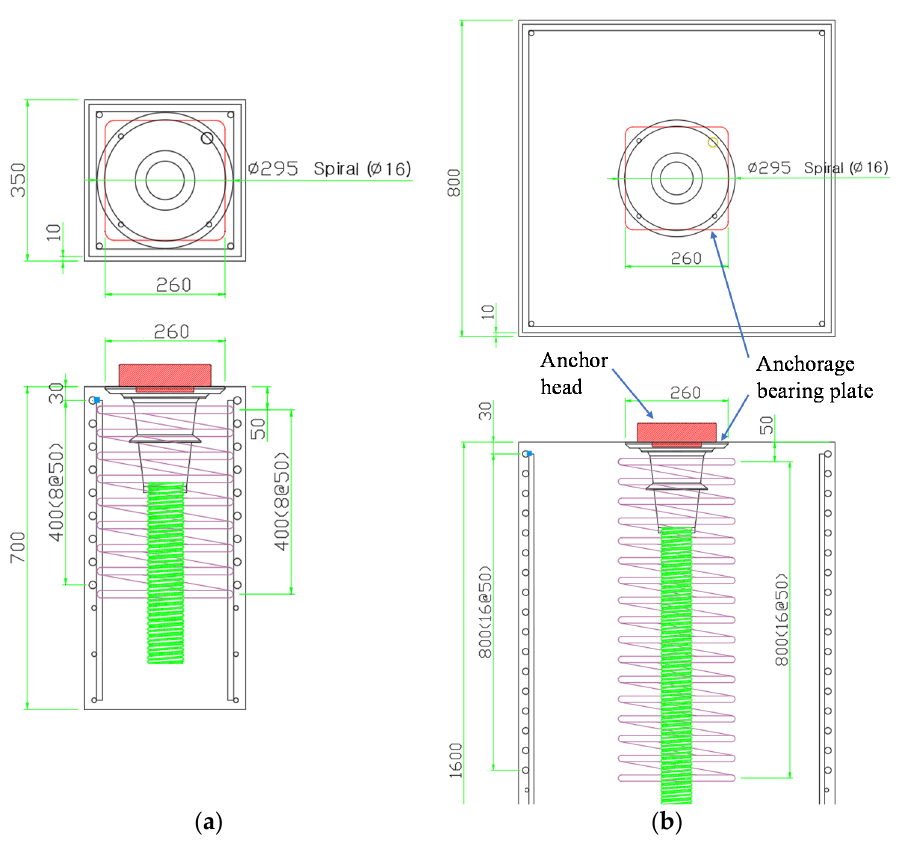
Figure 3. Representative drawings of test specimens: ( a ) A12H-1; ( b ) A12H-3.